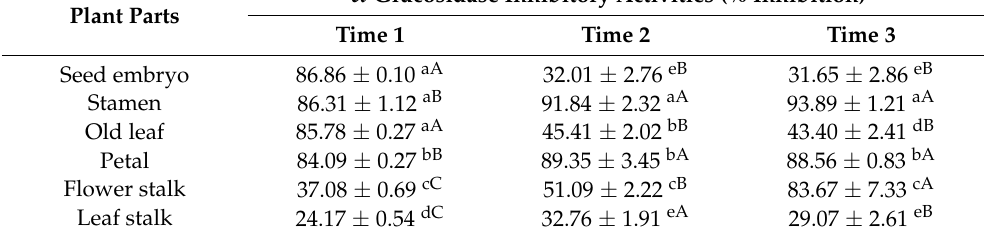
Table 8. α -Glucosidase inhibitory activities of different sacred lotus parts collected from different time